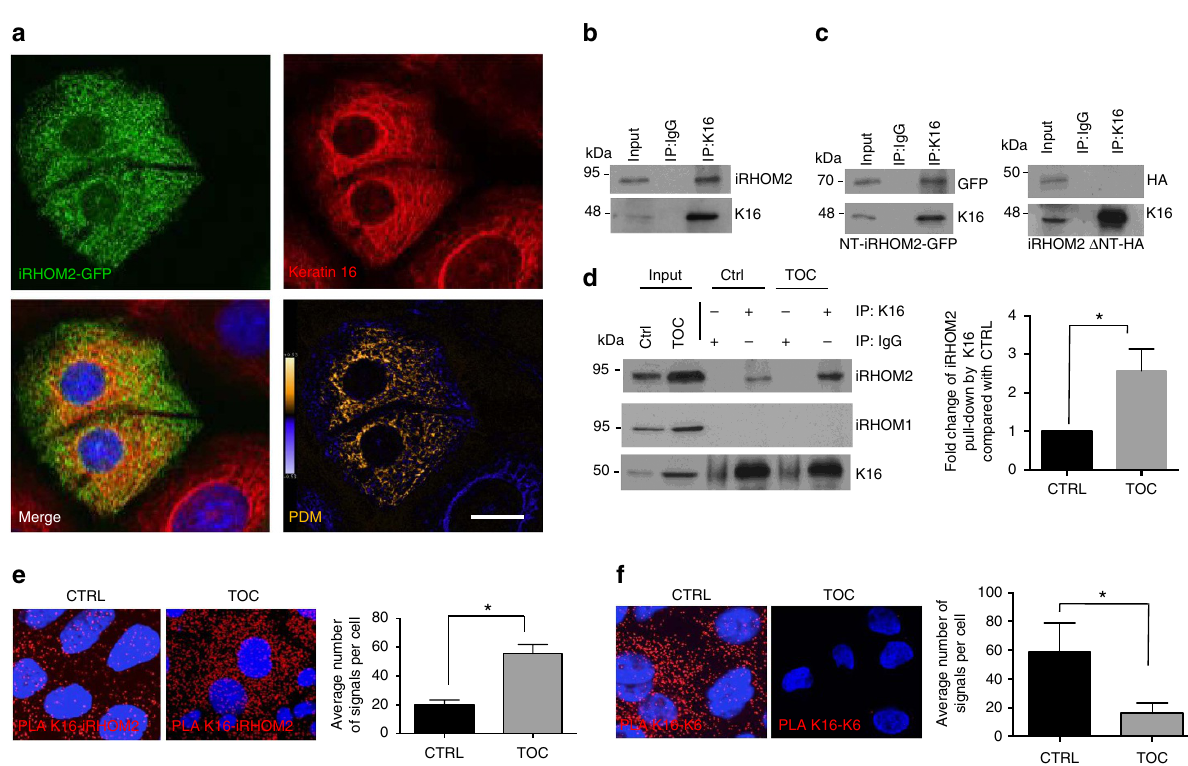
Figure 2 | The N terminus of iRHOM2 interacts with K16. ( a ) Confocal microscopy analysis of GFP-tagged iRHOM2 overexpressed in CTRL keratinocytes showing co-localization with endogenous K16. Pseudocoloured ‘product of the differences from the mean’ (PDM) images, in which each pixel is equal to the PDM value at that location, are shown with a PDM scale. Scale bar, 20 m m. ( b ) Control (CTRL) keratinocyte lysates were immunoprecipitated with anti-K16 antibody and immunoblotted with anti-iRHOM2 antibody. ( c ) Left panel: cell extracts from CTRL keratinocytes transfected with a vector expressing NT- iRHOM2-GFP were immunoprecipitated with anti-K16 antibody and analysed by western blotting with anti-GFP and anti-K16 antibodies. Right panel: cell extracts from CTRL keratinocytes transfected with a vector expressing HA-tagged iRHOM2 lacking its N terminus (iRHOM2- D NT-HA) were immunoprecipitated with anti-K16 antibody and analysed by western blotting with anti-HA and anti-K16 antibodies. ( d ) CTRL and TOC keratinocyte lysates were immunoprecipitated with anti-K16 antibody and analysed by western blotting with anti-iRHOM1 and anti-iRHOM2 antibody. Graph depicting fold change of iRHOM2 pull-down by K16 in TOC cells compared with CTRL ( n ¼ 3); error bars denote s.d., * P o 0.05 (Student’s t -test). ( e ) PLA between iRHOM2 and K16 analysed by confocal microscopy in CTRL and TOC keratinocytes. Graph represents quantification of red fluorescent PLA signals relative to 4,6-diamidino-2-phenylindole (DAPI). Mean of 3 experiments, each experiment comprising 12 separate images. Error bars denote s.d. * P o 0.05 (Student’s t -test). Scale bar, 20 m m. ( f ) PLA between K6 and K16 analysed by confocal microscopy. The graph shows quantification of red fluorescent PLA signals relative to DAPI. Mean of 3 experiments, each experiment comprising 12 separate images. Error bars denote s.d.* P o 0.05 (Student’s t -test). Scale bar, 20 m